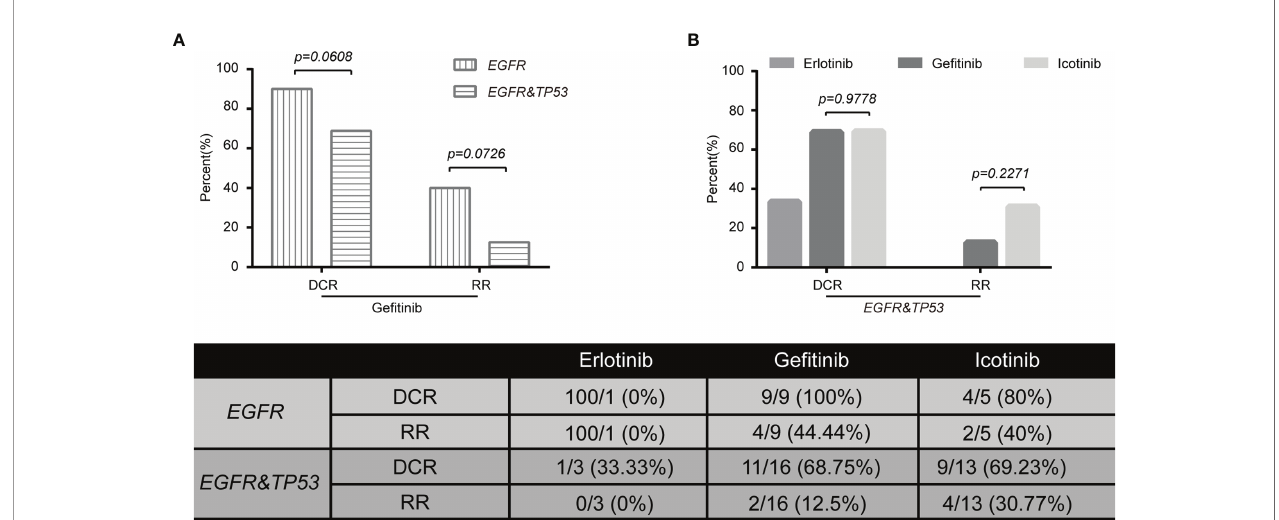
FIGURE 6 | The tumor response to Ge fi tinib was associated with genomic subtyping in NSCLC (A) . The comparative analysis of p53 mutations for patients treated with targeted agents (B) . DCR, disease control rate (complete response + partial response + stable disease). PD, progressive disease; EGFR , NSCLC with EGFR but not TP53 alterations (n = 15); EGFR&TP53 , NSCLC with EGFR and TP53 co-alterations (n = 32). Note: Tumor response data were only collected from patients with advanced disease (stages III and IV) who were fi rst treated with targeted agents. The group including more than fi ve patients was used to do statistical analyses.